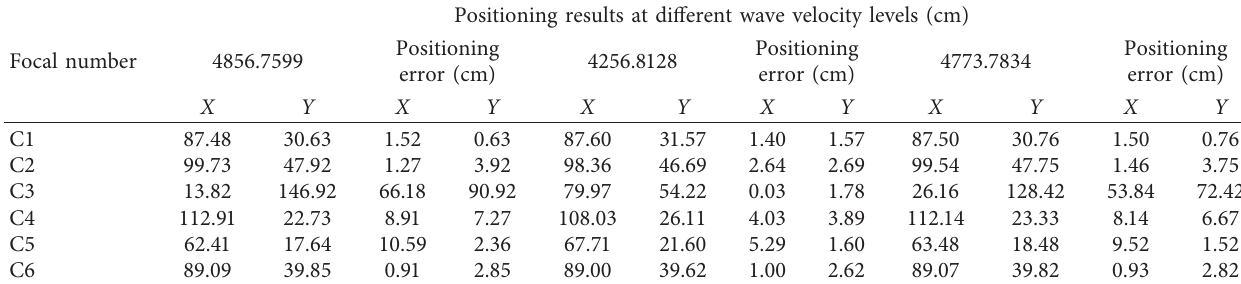
Table 14: Source location results for Scheme I of GAM-L.